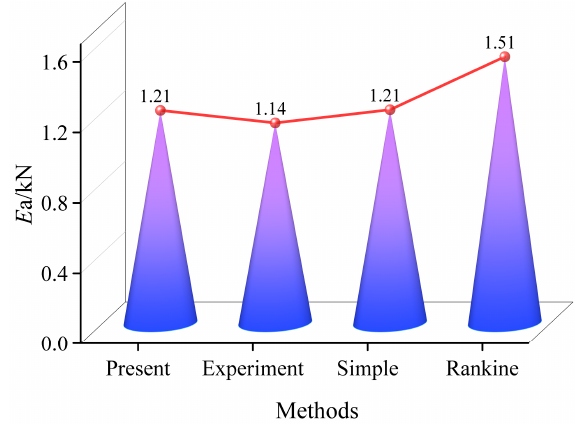
Figure 16. Resultant force of finite soil pressure compared with experiment.